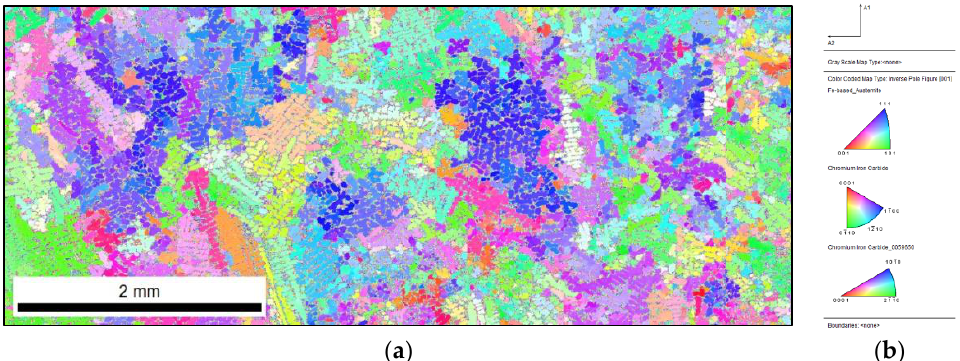
Figure 11. ( a ) Inoculated sample with 0.66% Fe – Ti: IPF map with marked primary grains; ( b ) refer- ence triangle.